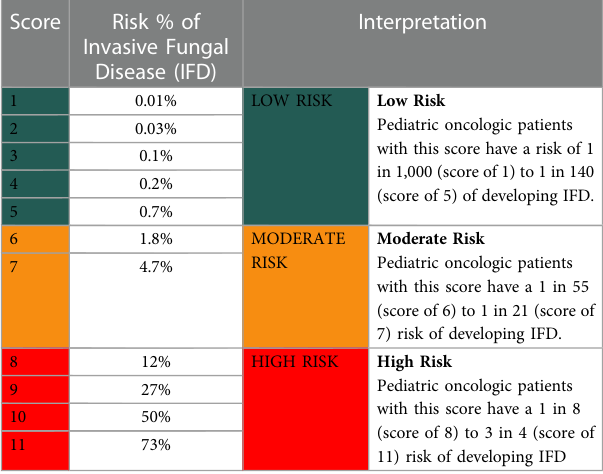
TABLE 2 Patient risk score